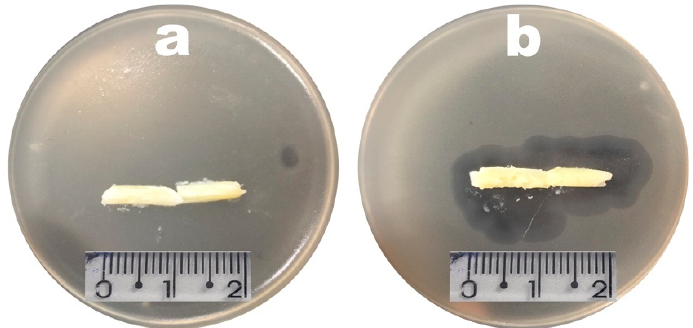
Figure 12. Results from evaluation of the maintenance of lytic activity of the phage particles upon integration within the bioactive cocoa butter matrix and concomitant stabilization of both their structure and function. ( a ) Cocoa butter matrix devoid of phage particles; ( b ) bioactive cocoa butter matrix integrating the cocktail of phage particles. Full scale bar represents 2 cm.